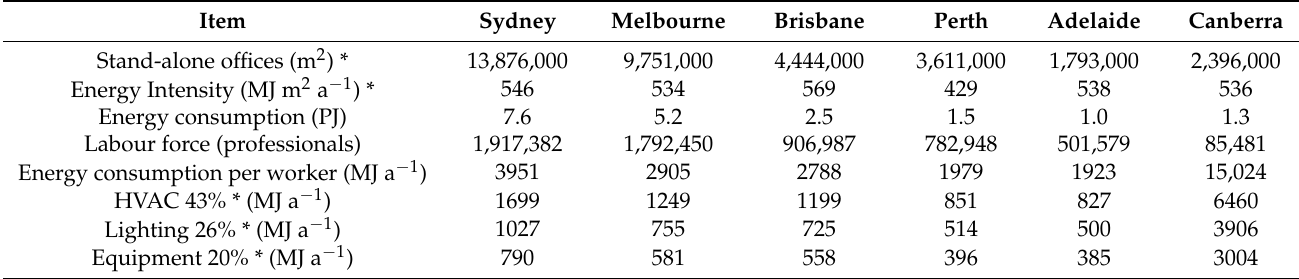
Table A2. Commercial building related data (S 0 ).